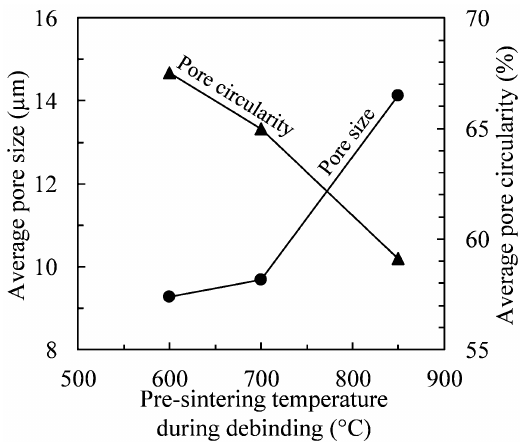
Figure 10. Average pore size and circularity as functions of pre-sintering temperature.